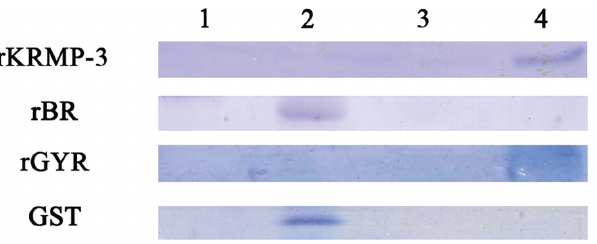
Fig 4. Chitin-binding assay. Lane 1, water-washings; lane 2, 0.2 M NaCl-washings; lane 3, 1 M acetic acid- washings; lane 4, extract with detergent-SDS/ β -mercaptoethanol for 10 min at 100°C. GST was used as a negative